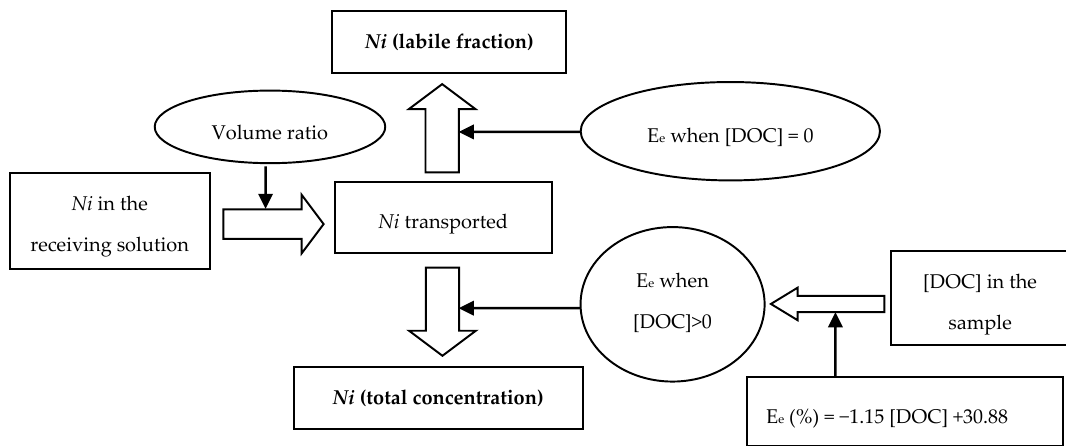
Figure 3. Speciation diagram using the liquid membrane system.